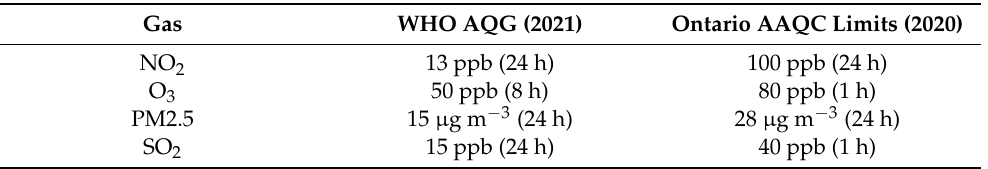
Table 1. Short-term outdoor exposure limits outlined in the most recently published Ontario AAQC [9] and the recently published 2021 WHO AQG Criteria